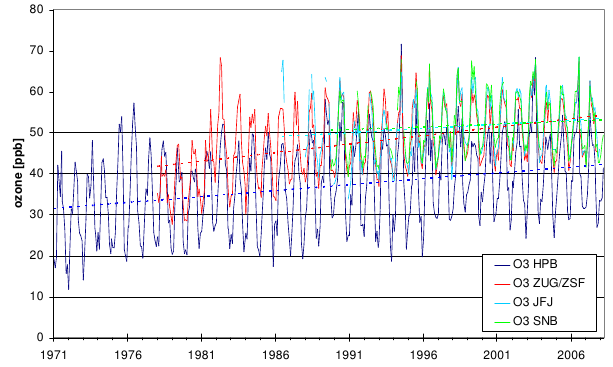
Fig. 1. O 3 time series at the respective “DACH”-sites: blue: HPB; red: ZUG/ZSF, light blue: JFJ, green: SNB. Monthly mean mixing ratios (solid) and linear trend Figure 1. O 3 time series at the respective „DACH“-sites: blue: HPB; red: ZUG/ZSF, light 6 blue: JFJ, green: SNB. Monthly mean mixing ratios (solid) and linear trend (dashed) 7